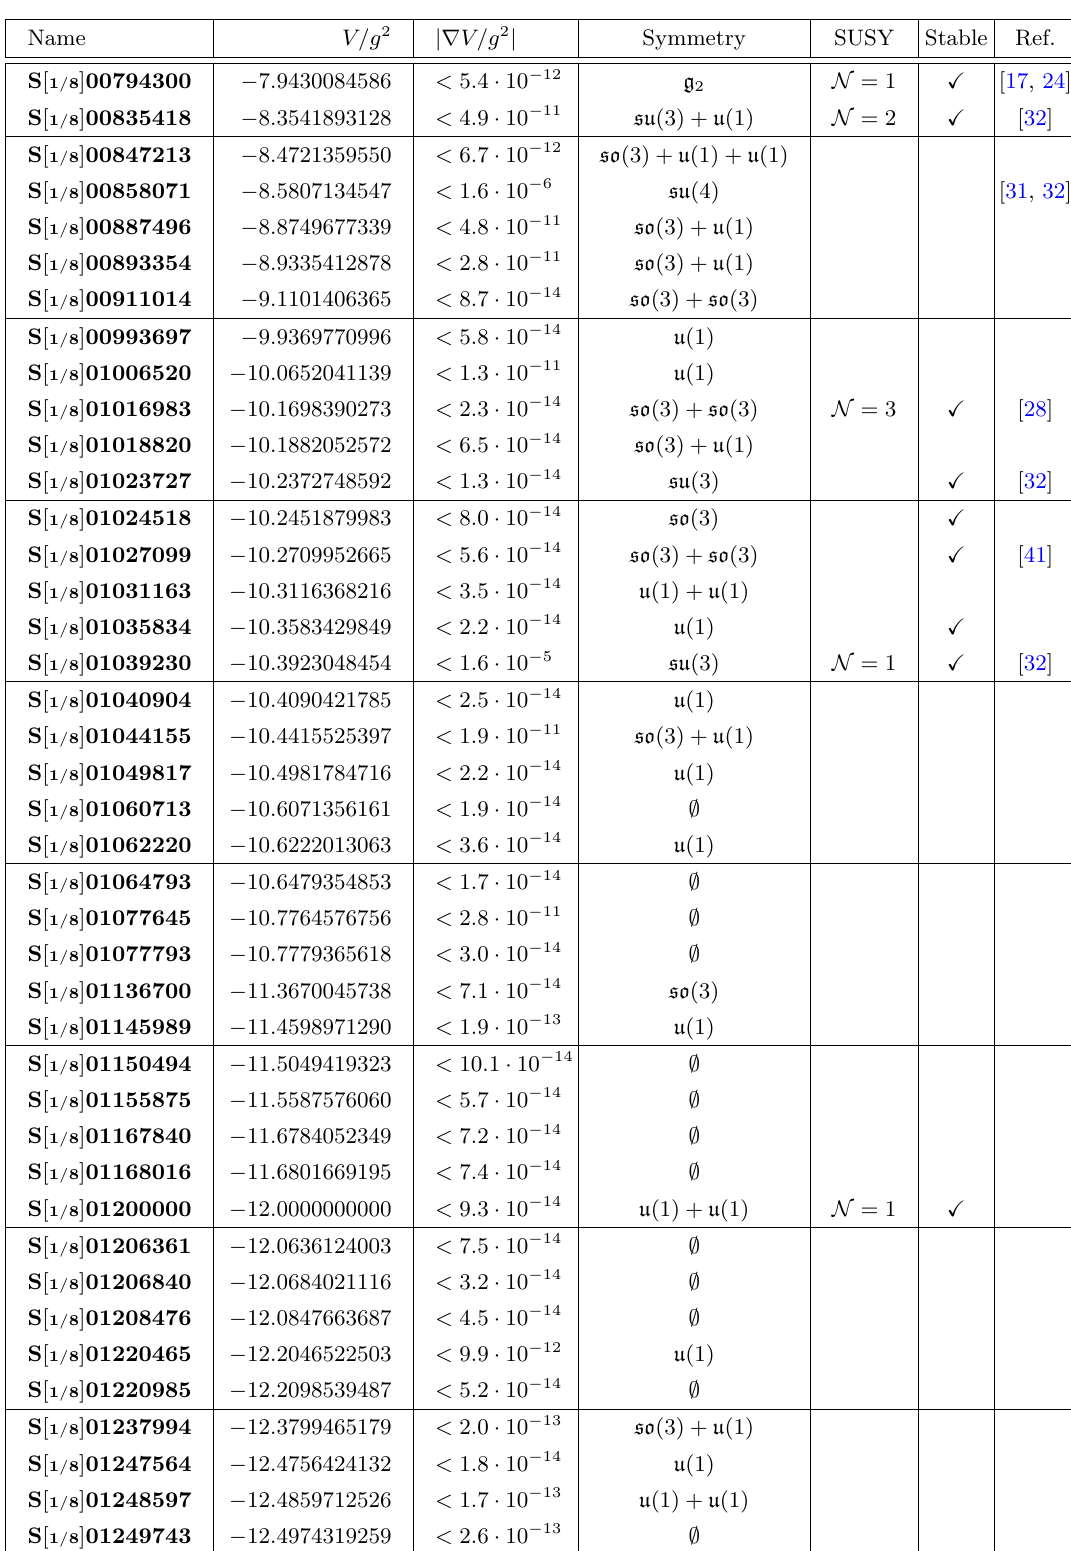
Table 1. Summary of vacua at ω = π/ 8